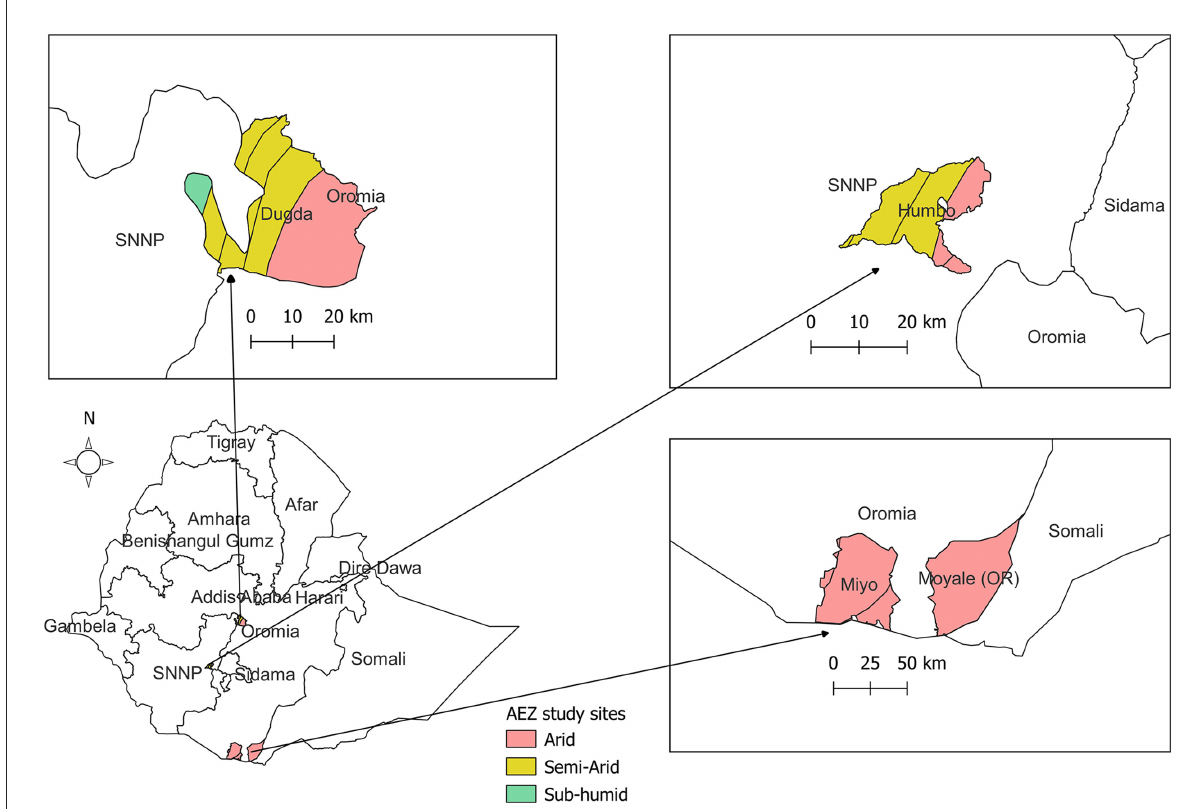
FIGURE1 The location of the study areas in Ethiopia. Humbo in Southern Nation Nationality and People (SNNP) regional state and Dugda, Moyale and Miyo in Oromia regional state. Gray line indicates regional boundaries of Ethiopia. AEZ, agroecolog